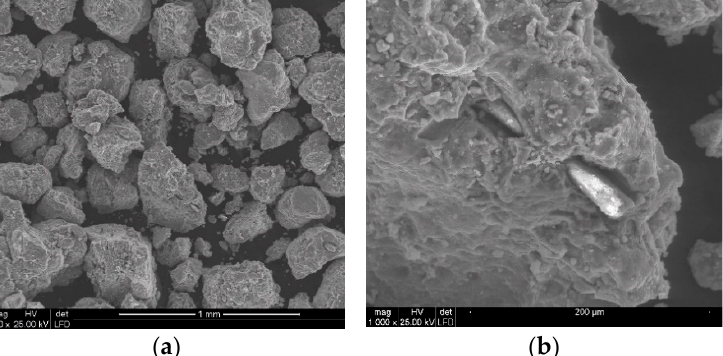
Figure 12. Example SEM images of concretion particles comminuted in a waterjet mill (for d w = 0.7 mm, d h = 2.4 mm, s = 10 mm, p = 70 MPa): ( a ) general view, ( b ) surface development.